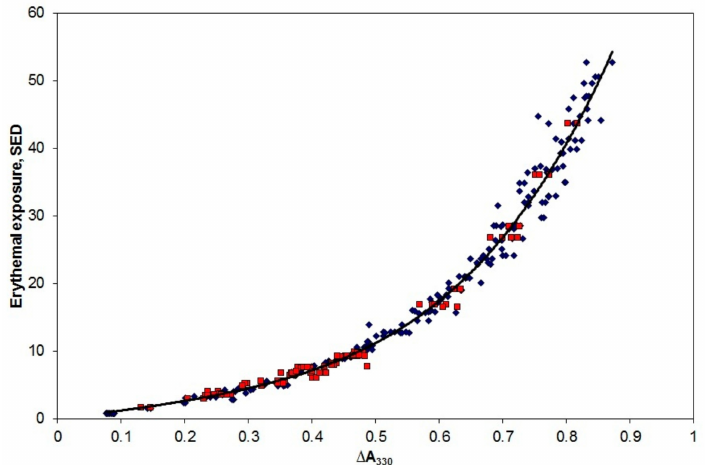
Figure 3. Exposure of PSP film badges to sunlight in Queensland (blue diamonds) and Victoria (red squares). The solid black curve is a quartic fit to the data. The solid line is an equation of the form: Erythemal dose (SED) = 10.7 [ ∆ A 330 ] + 14.3 [ ∆ A 330 ] 2 − 26.4 [ ∆ A 330 ] 3 + 89.1 [ ∆ A 330 ]